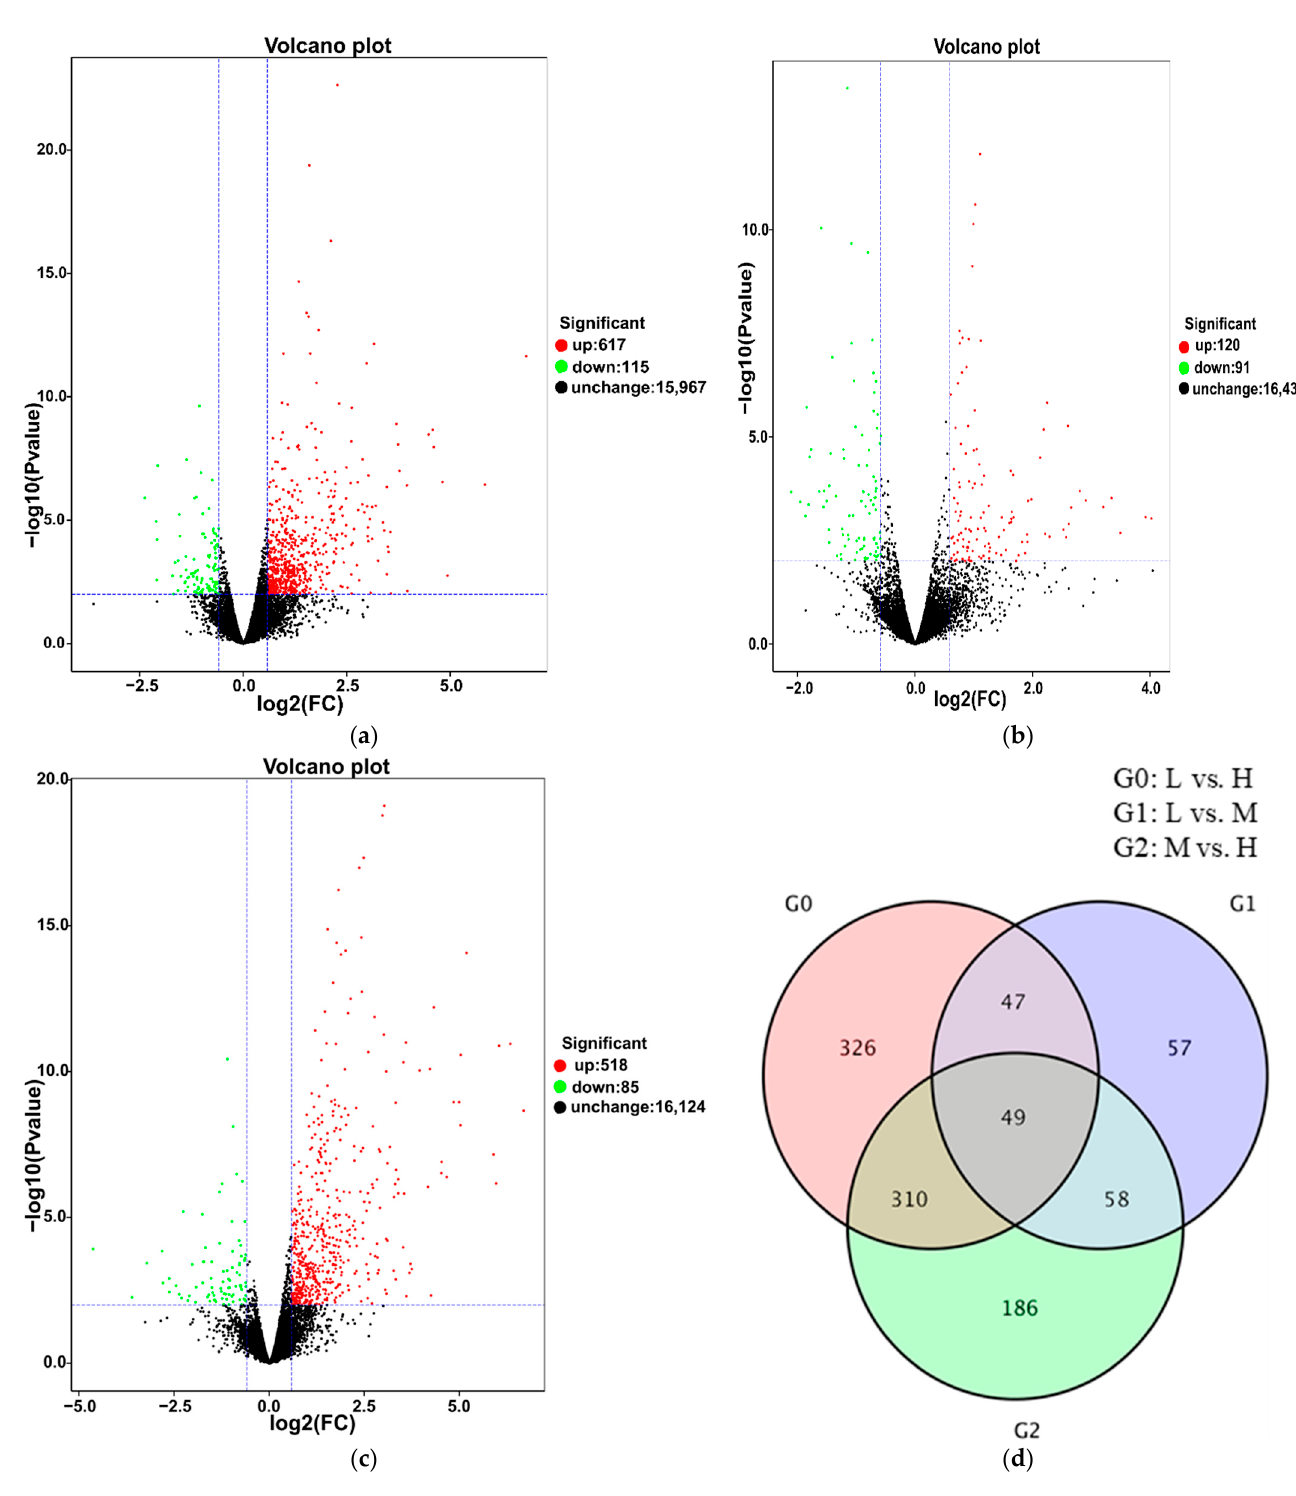
Figure 4. Differential expression volcano map of L vs. H, L vs. M, and M vs. H at the E-L 36 stage, respectively ( a – c ). Venn diagram depicting the shared and unique differentially expressed genes (DEGs) identified by RNA-Seq analysis between grapes at the E-L 36 stage ( d ). Each point in the differential expression volcano map represents a gene, and the abscissa represents the logarithm of the multiple of the differential expression of a gene in the two samples. The ordinate represents the negative logarithm of statistically significant changes in gene expression. The green dots represent downregulated differentially expressed genes, the red dots upregulated differentially expressed genes, and the black dots non-differentially expressed genes.